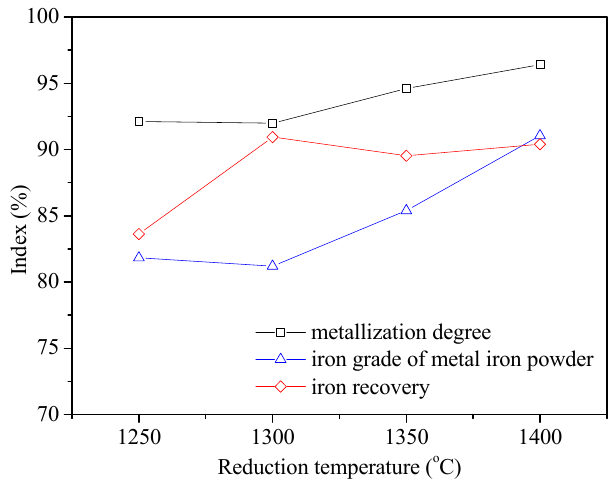
Figure 10. Effect of the reduction temperature on the reduction and separation indexes (reducing for 20 min with a total C/Fe mass ratio of 1.0, 15% coal blended in pellets).